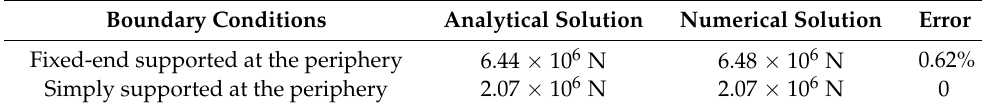
Table 5. Critical loads for instability of circular SP-HCs under different constraints. Fixed-end supported at the